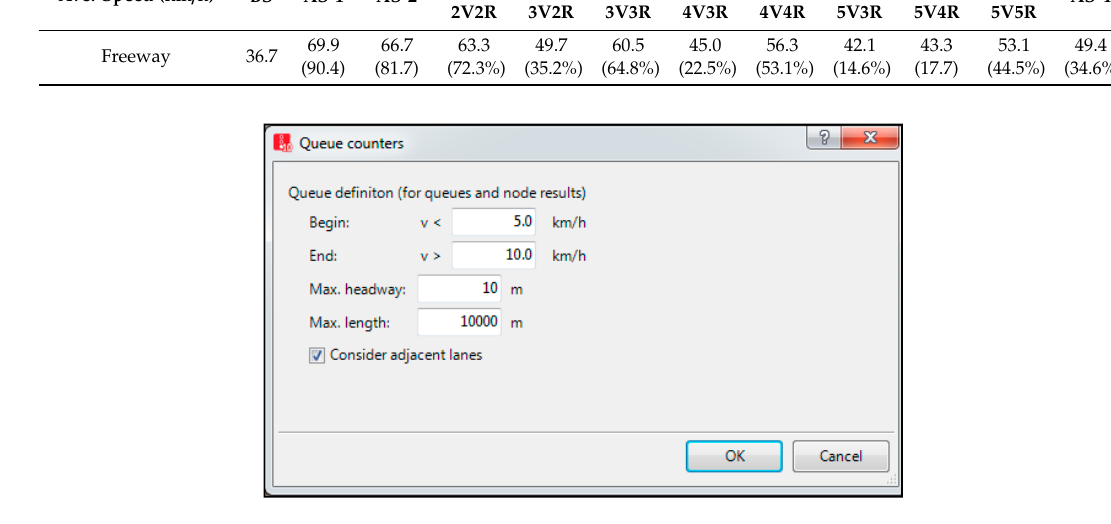
Figure 6. Inputs for the queue counters in VISSIM.